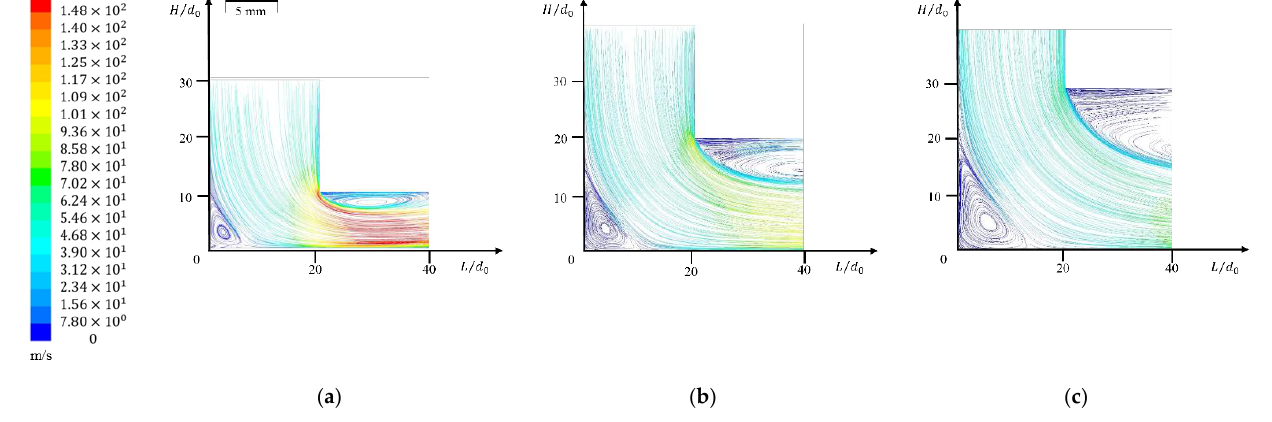
Figure 7. Velocity contours and streamlines with the fixed mass flow rate of 77g/s and three different channel heights: ( a ) 𝐻 𝑑 0 ⁄ = 10; ( b ) is 𝐻 𝑑 0 ⁄ = 20; and ( c ) 𝐻 𝑑 0 ⁄ = 30.